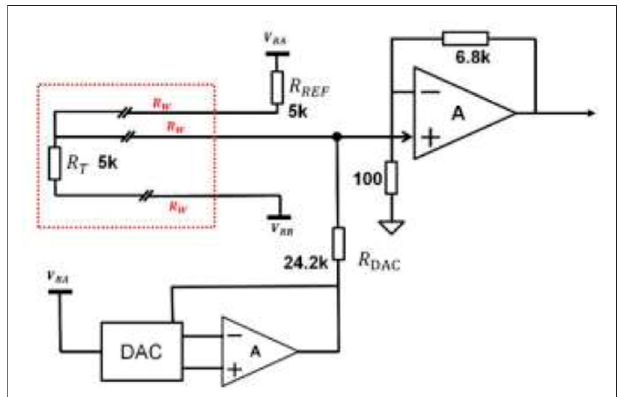
FIGURE 2 | Schematic diagram of the measurement